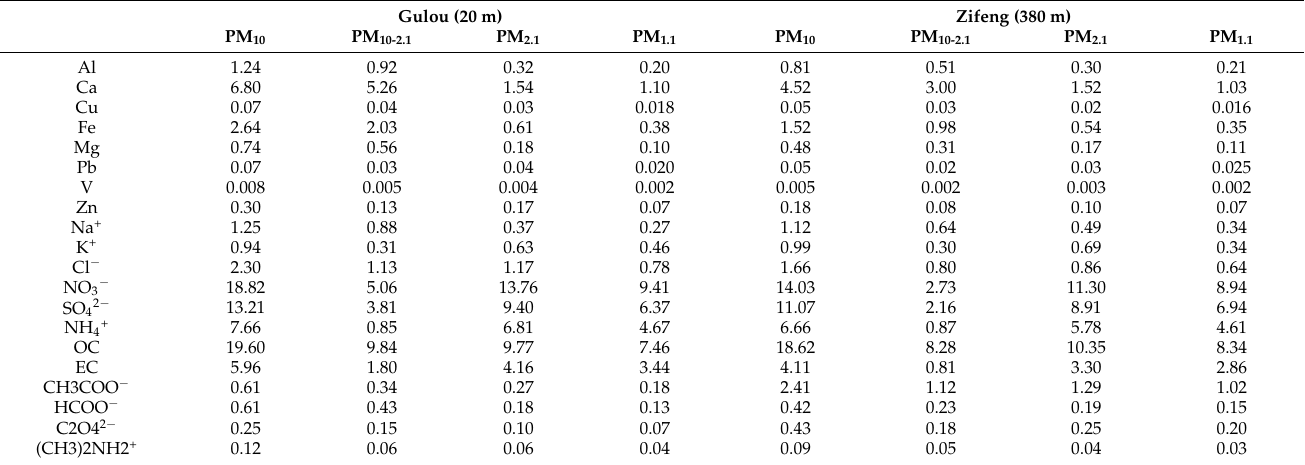
Table 3. The average mass concentrations of main chemical compositions at each sampling height in